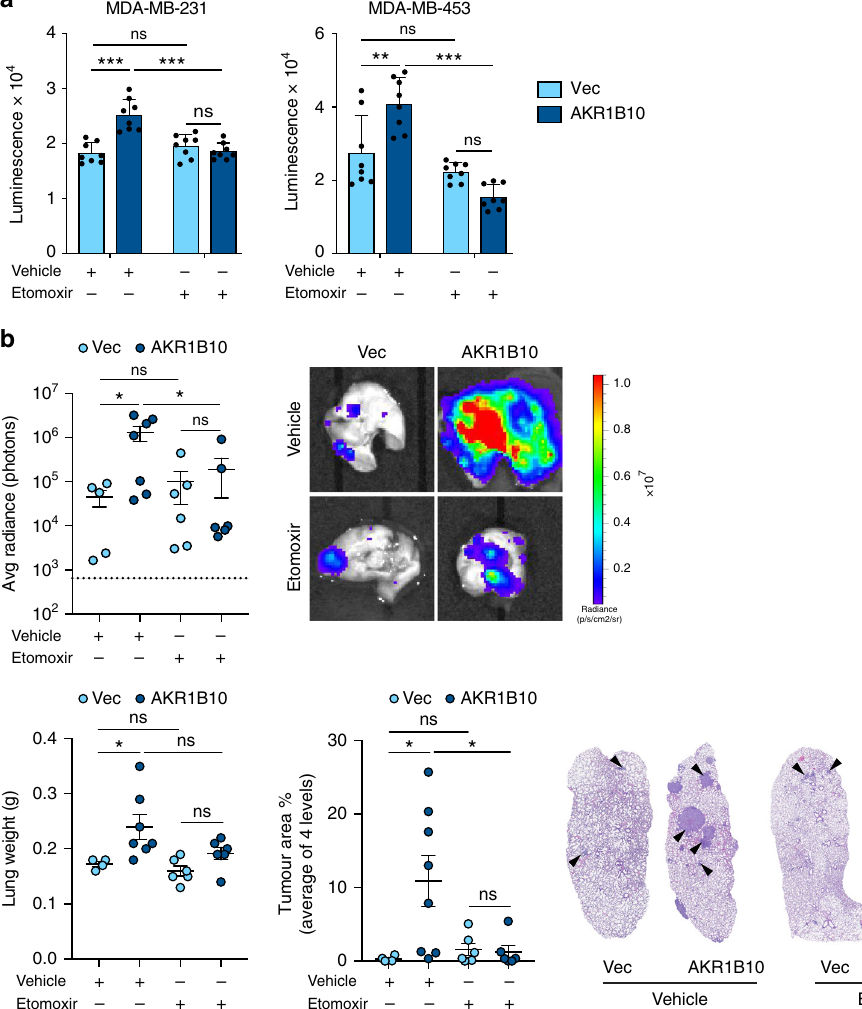
violet, dried and scanned at 1200 dpi using the GelCount colony counter system. Images were analysed using Fiji. Cell viability assay : 1 ×10 2 cells in 100 µL medium were seeded per well in a 96- well plate and incubated at 37 °C. Immediately after seeding, and every 24 h afterwards, cells viability was analysed by CellTiter-Glo (Promega). Fold change was calculated relative to the plate read at seeding (time 0). For 3D viability assays, 5× 10 3 cells were seeded into ultra-low adherence U-bottomed 96-well plates (Corning). On day 6 tumour spheroids were lysed in CellTiter-Glo for 30min and viability analysed using a Victor X5 plate reader. Where indicated, etomoxir (200 μ M) or vehicle (DMSO) was added 24h after seeding. 2D cell growth : 1 ×10 3 cells were seeded per well in a 96-well plate and subject to live cell imaging (IncuCyte S3 — Essen Bioscience) every 12 h for 4.5 days. Phase contrast images were collected, a con fl uence mask applied to the segmented images and analysed using IncuCyte integrated con fl uence algorithm). Anoikis assay : 5× 10 4 cells per well were seeded into low-adherence 6-well plates (Costar) in DMEM containing 2% FBS. At 24h post-seeding, cells were stained with Annexin V-APC/PI Apoptosis Detection Kit (eBioscience) and analysed using a BD Biosciences LSRII fl ow cytometer with FACSDIVA and FlowJo software. Cell viability was measured as a proportion of healthy (Annexin- negative, PI-negative) cells.